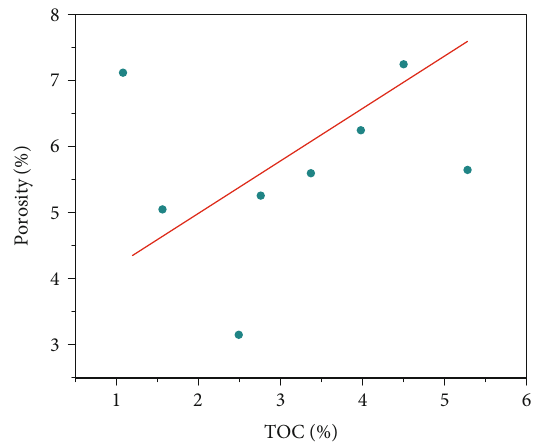
Figure 4: Relationship between porosity and TOC of the deep Longmaxi Formation shale samples.